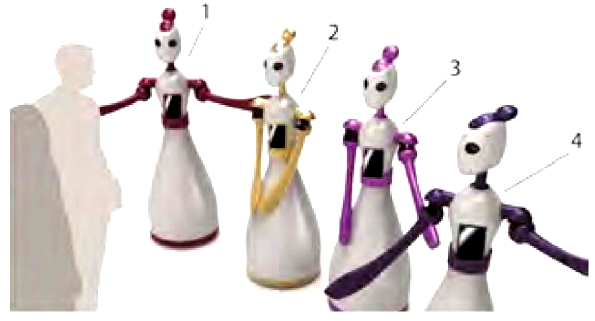
Figure 9: Example of layered modality from [41].